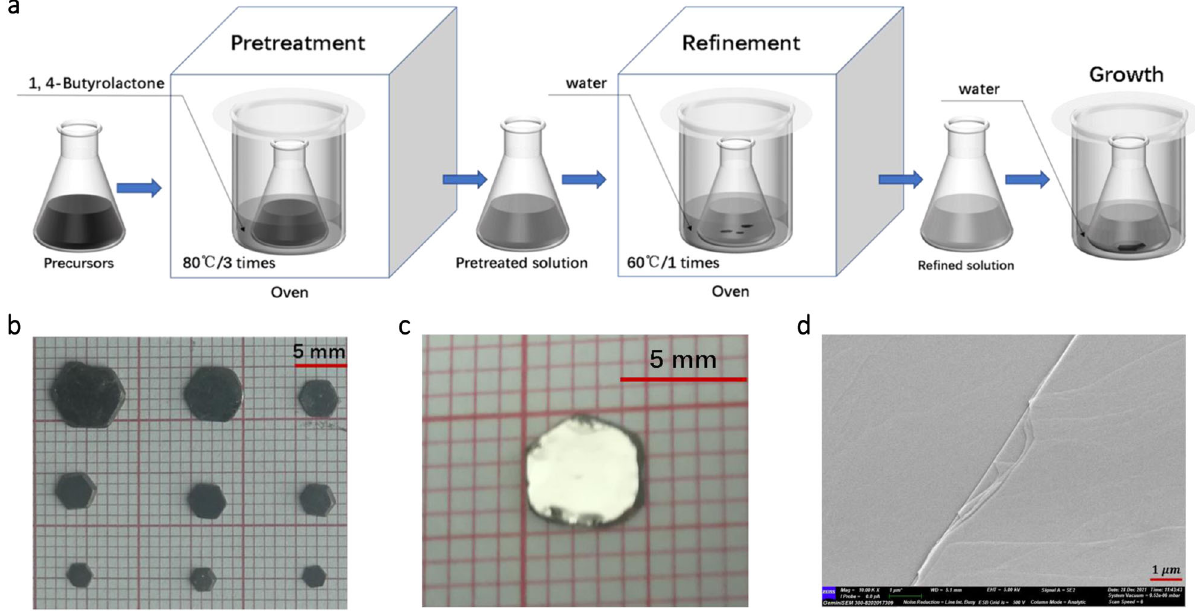
Fig. 1 | Preparation and characterization of Bi x I y . a A typical growth procedure forBi x I y includessolutionpretreatment, solutionre fi nement and crystalgrowth in room temperature water bath. b Optical image of as-grown crystals. c A typical